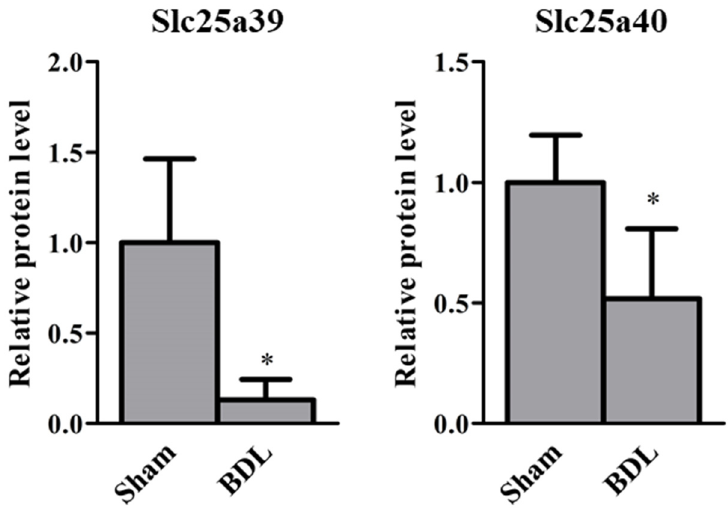
Figure 4. Relative protein levels of Slc25a39/40 in the kidneys of sham and bile duct ligation (BDL) mice. The results are expressed as the mean ± S.D. of each group (n = 3 − 4). Significant differences (* p < 0.05) between sham and BDL mice were observed.